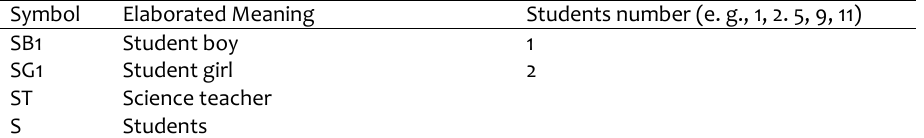
Annex A: Elaborated meaning of symbols used for Research